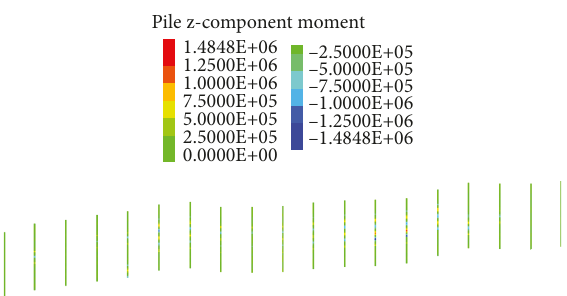
Figure 24: Pile bending moment distribution under straight line layout.